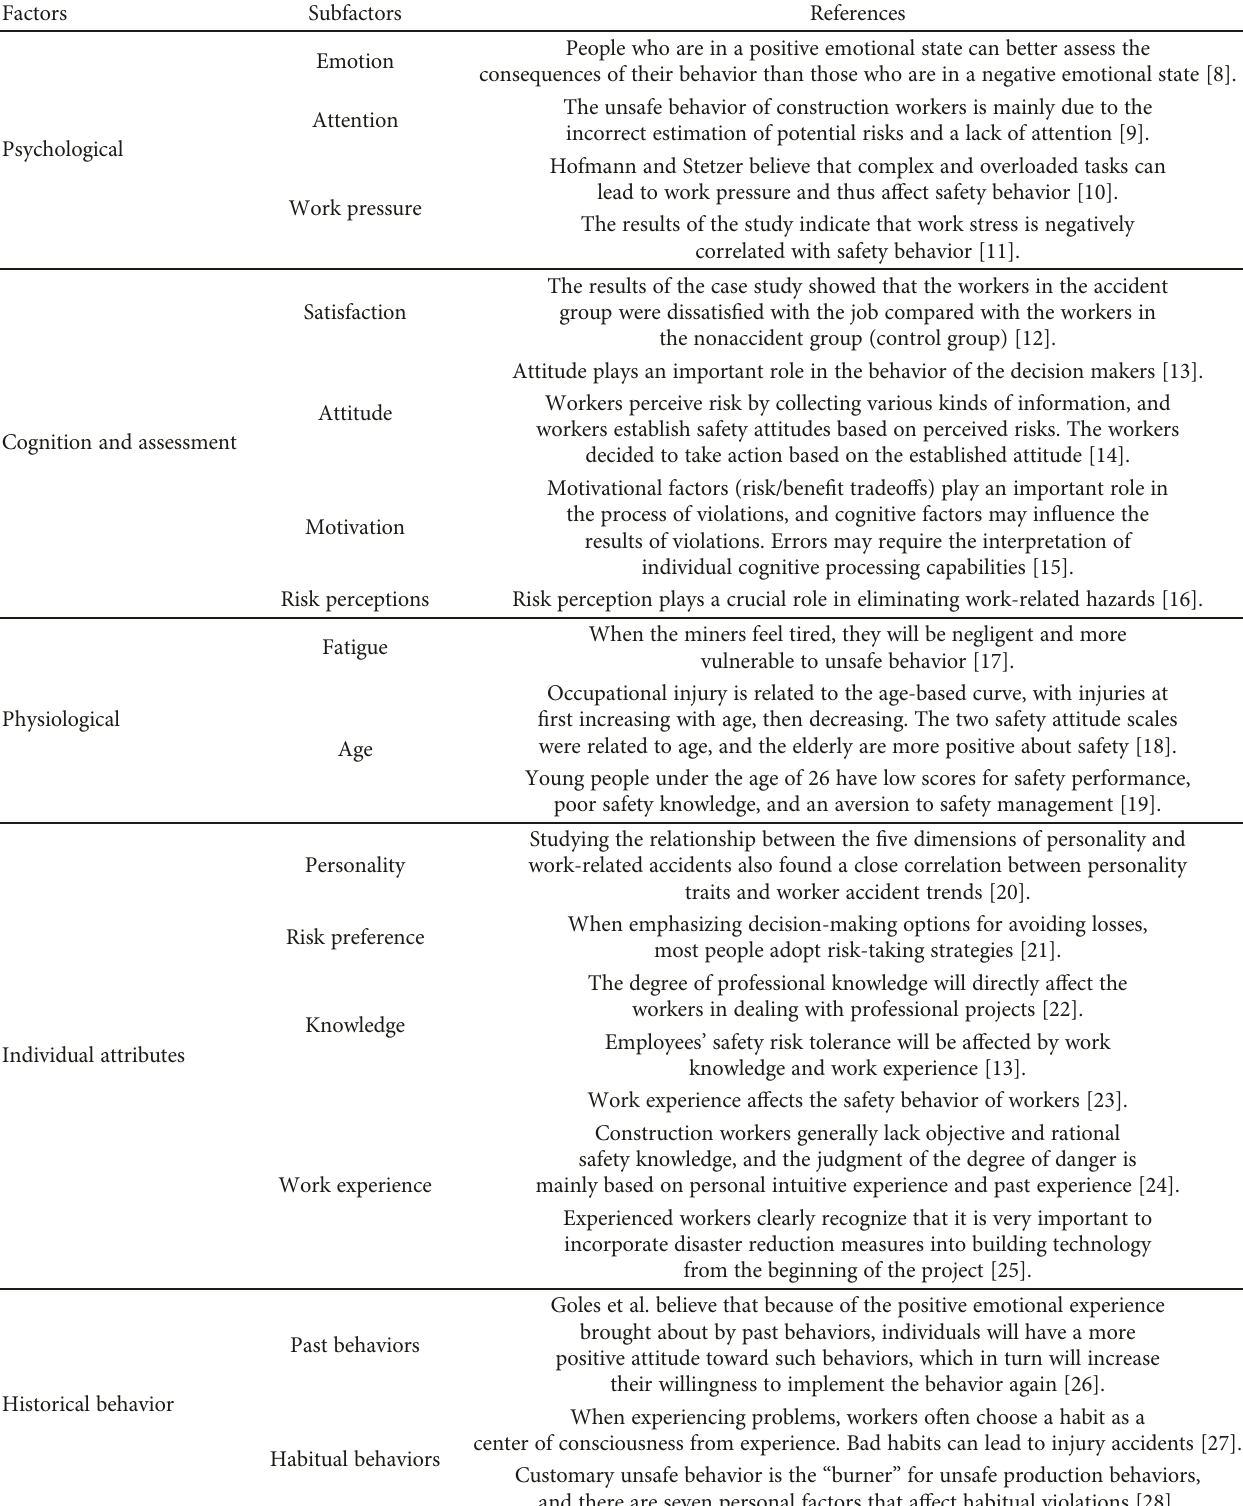
Table 1: Cognitive and decision-making studies on unsafe behavior in construction